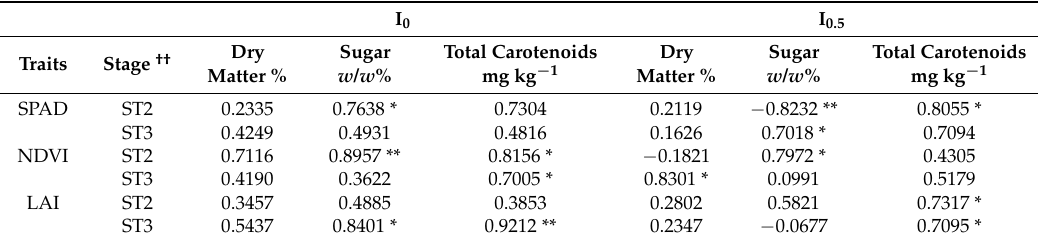
Table 5. Correlation coefficients ( r ) between the physiological traits and yield quality of sweet corn under unirrigated (I 0 ) and moderate water deficit (I 0.5 )